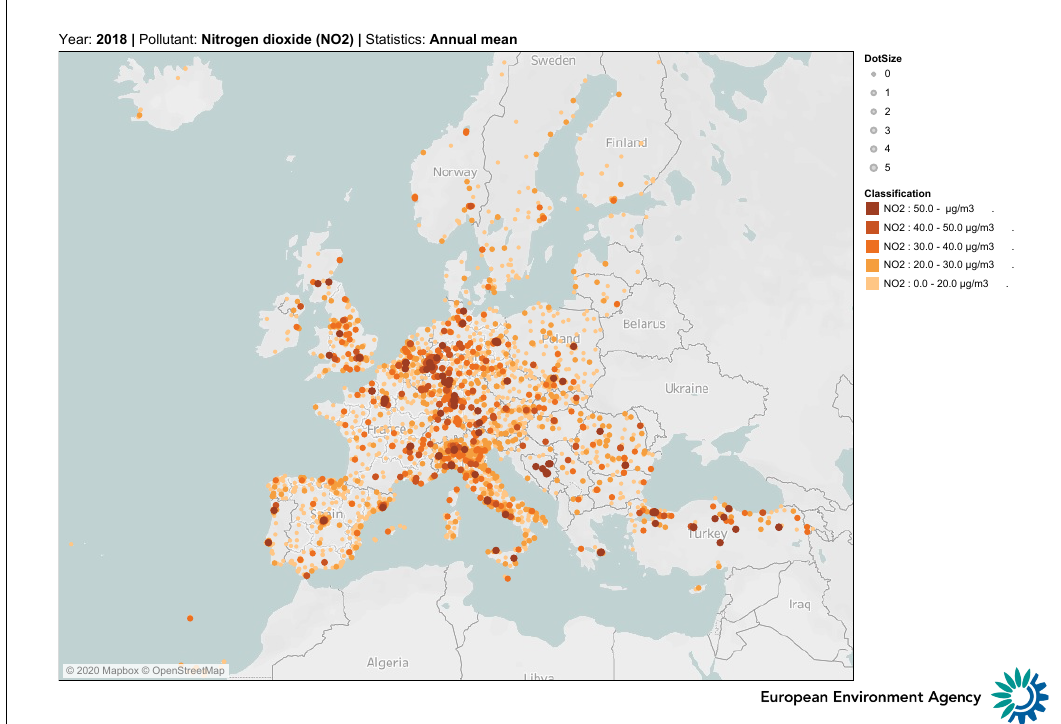
Figure 1. Annual average NO 2 concentrations ( µ g/m 3 ) in Europe during 2018. Levels are expressed in µ g/m 3 . Source: European Environmental